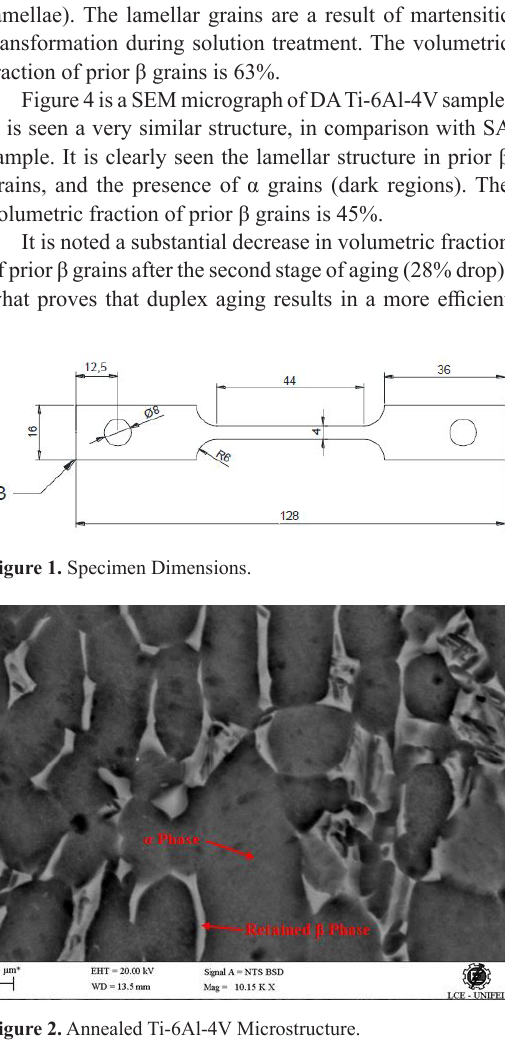
Figure 4 is a SEM micrograph of DA Ti-6Al-4V sample.